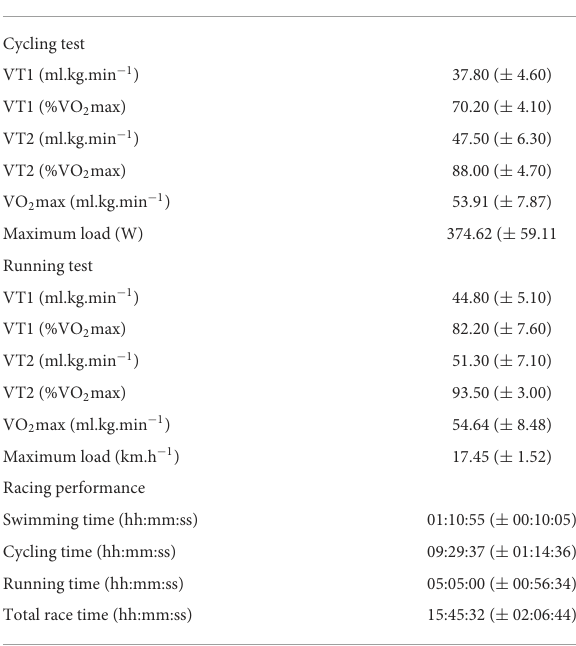
TABLE 1 Data related to anthropometric, metabolic, and performance characteristics of the athlete volunteers in the study. Variables